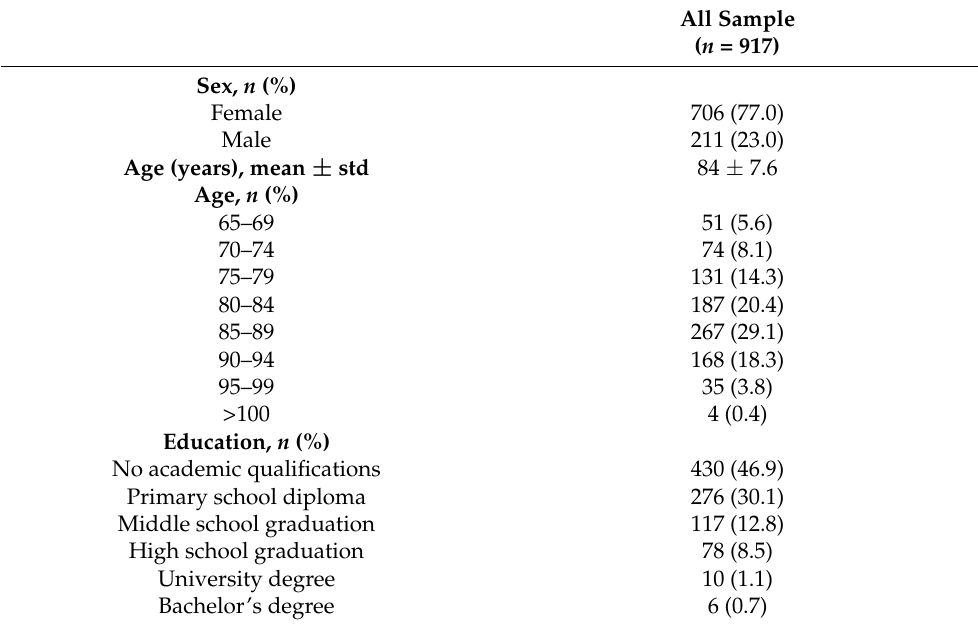
Table 1. Basal demographic data of the study